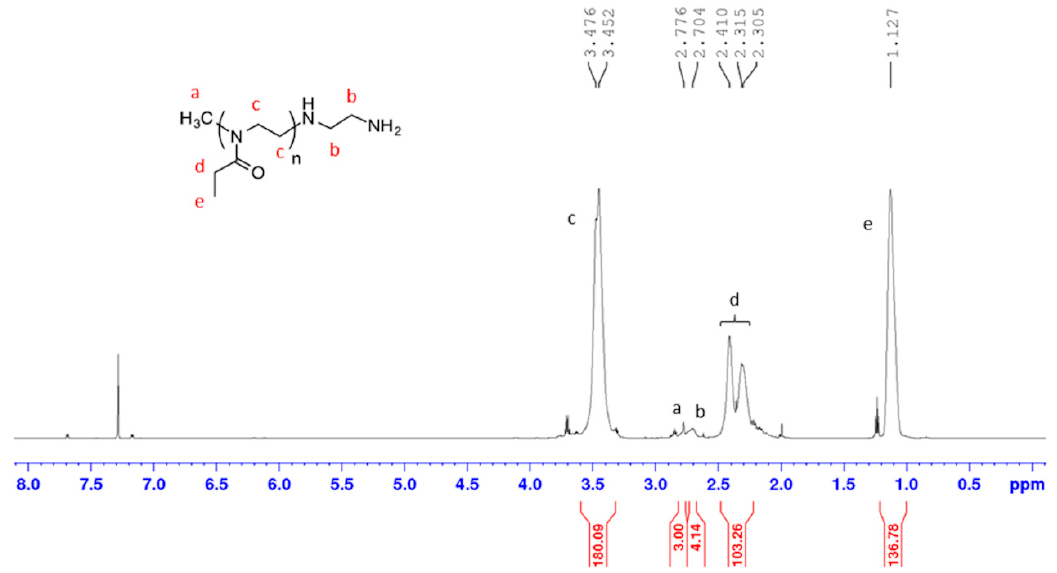
Figure 1. 1 H NMR spectrum of amine-end functionalized PEtOx (400 MHz, solvent CDCl 3 ). Chemical shifts: δ 1.13 (br s, H e ), 2.31–2.41 (m, H d ), 2.70 (br s, H b ), 2.78 (s, H a ), and 3.45–3.48 (m, H c ). The horizontal axis is the chemical shifts of proton signals in parts per million (ppm). The red numbers below the axis reflect the abundance of the individual protons. H indicates proton or hydrogen of the molecule.